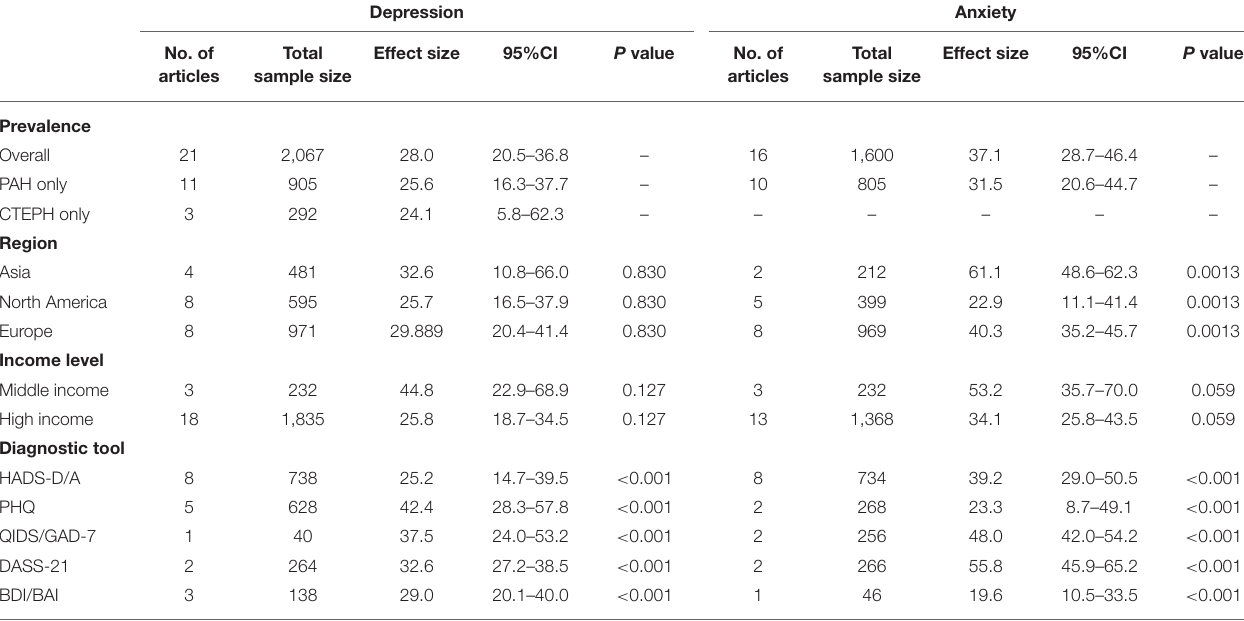
TABLE 2 | Prevalence and subgroup analyses of depression and anxiety in patients with PH.